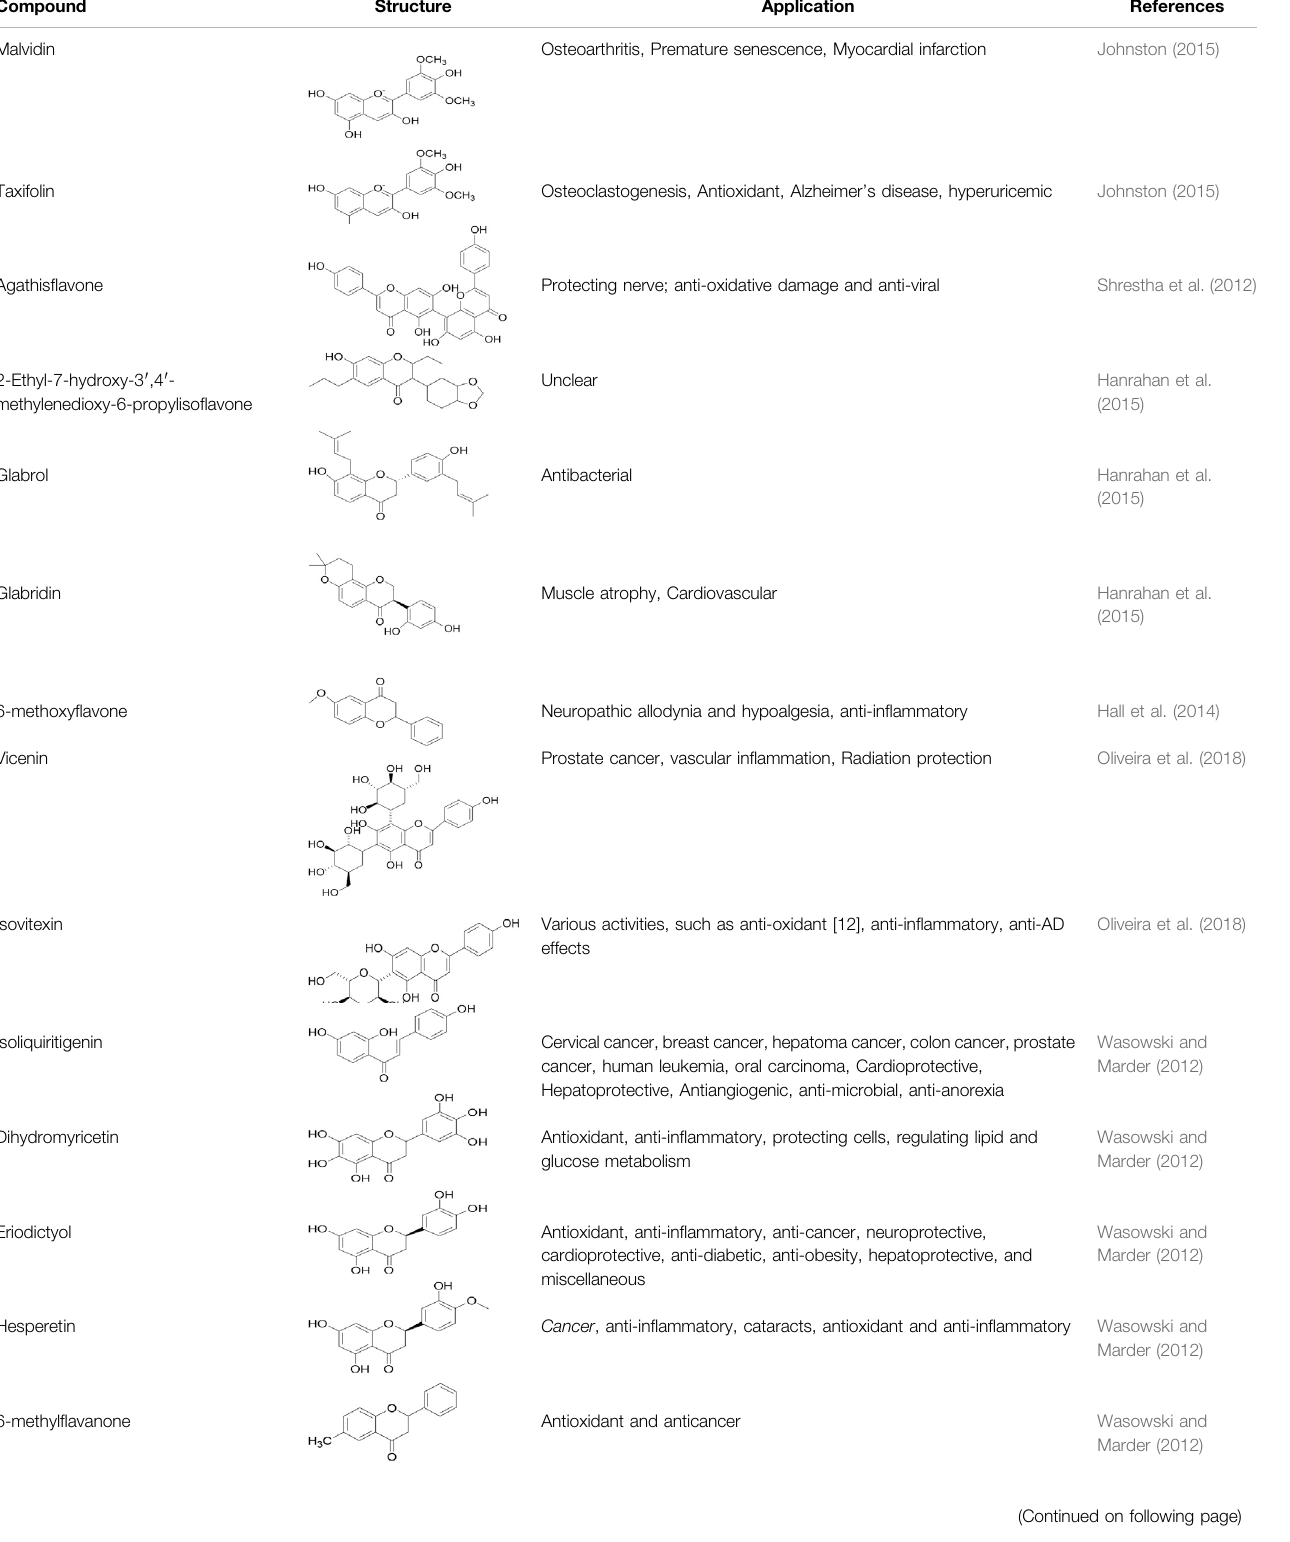
TABLE 8 | A monomer compound derived from a natural drug that modulated ionotropic GABA